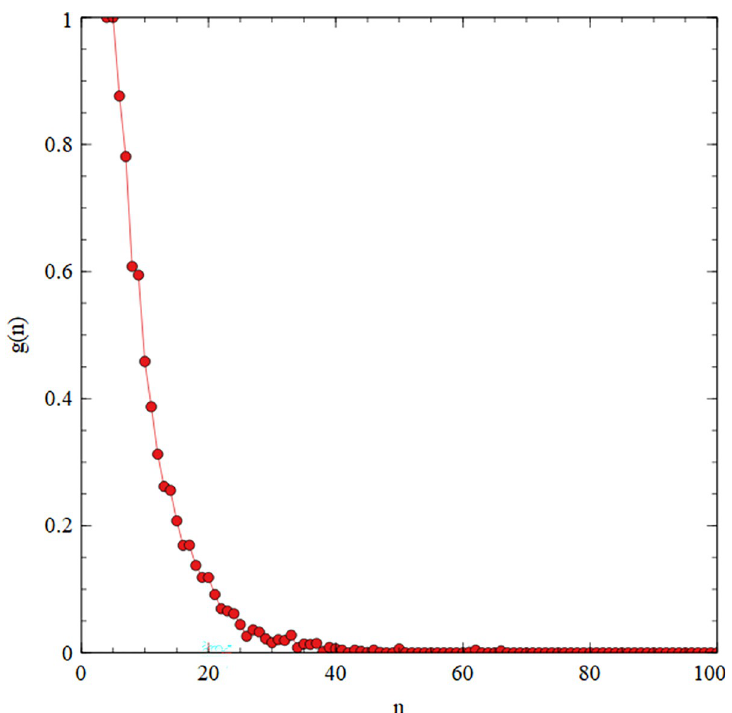
Fig 13. Simulation beginning with the fragments of the F ribozyme (as in Fig 12) using standard parameters. g(n) is the fraction of sequences of length n in the mixture that are still part of the ribozyme sequence or its complement after 1000 temperature